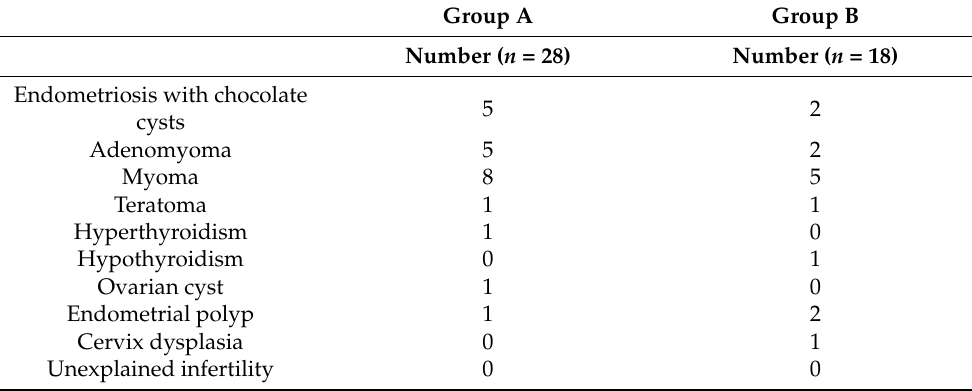
Table 2. Other causative factors of infertility in our subjects besides ovarian